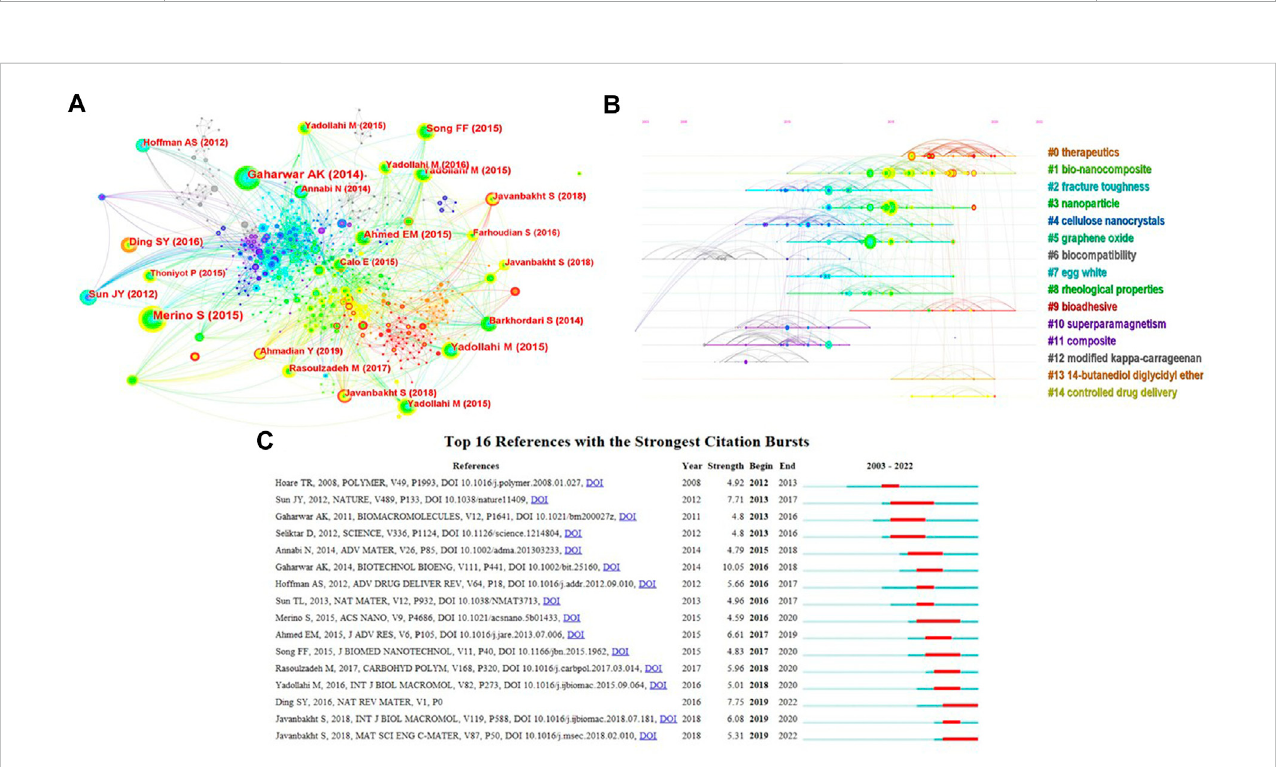
FIGURE 8 The analysis of references regarding the publications on the applications of NHs for drug delivery. (A,B) The visualized network map and clustering timeline of the co-cited references; (C) Top 16 References with the Strongest Citation Bursts.